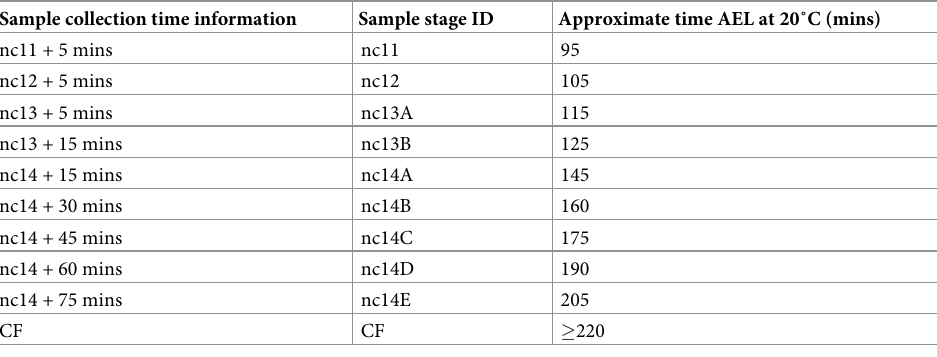
Table 1. Drosophila embryo samples collected for RNA-seq time course. Sample collection time